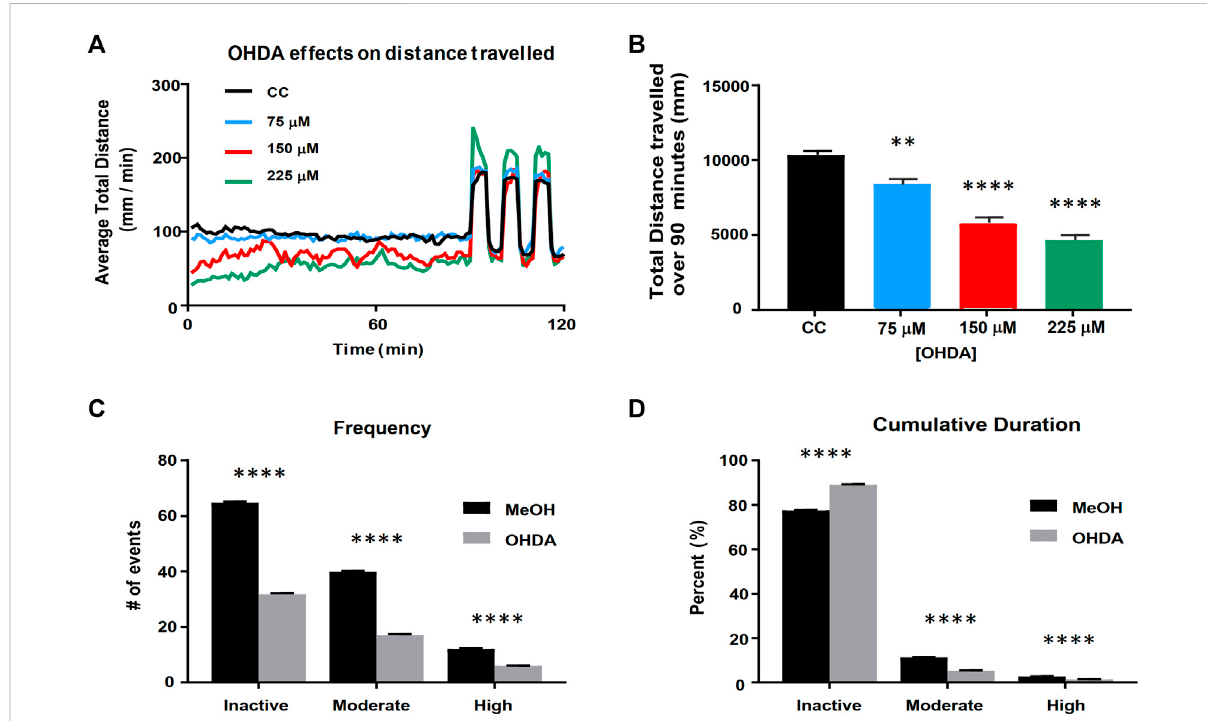
FIGURE 3 Validationofthelarvalzebra fi shOHDAmodel. Panel (A) Behavioralpro fi lesoftotaldistance traveled(60 sbins)followingOHDAexposure from 48 to 120 hpf. Panel (B) Total distance travelled during the fi rst 90 min in the light following OHDA exposure from 48 to 120 hpf (n = 36). Advanced activity analytics (C,D) of Total Frequency of switching between activity states (C) and the nested Cumulative Duration in each activity state (D) (n = 48). CC vs. OHDA, ** = p < 0.01 **** = p <